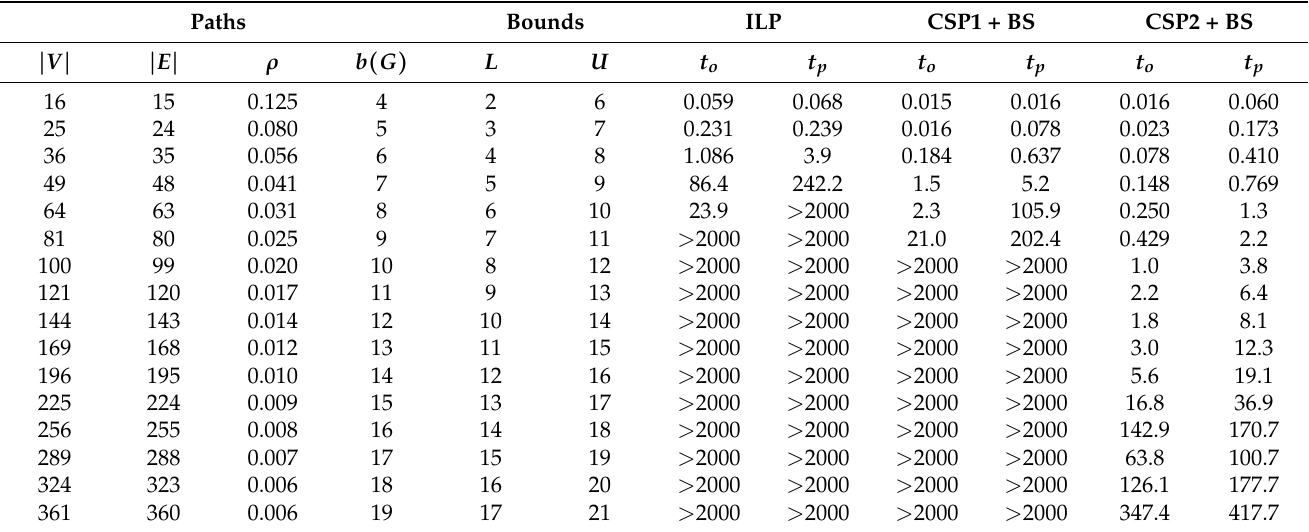
Table 1. Running time of the implemented mathematical formulations over a set of paths.